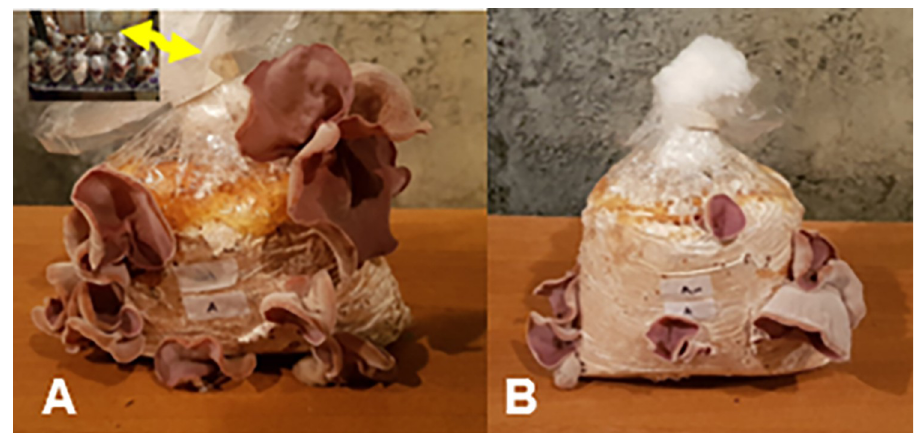
Fig 3. Auricularia cornea cultivation in “70% beech sawdust + 30% wheat bran” and “100% wheat bran” with moisture content of 70%, and pH = 6.5.